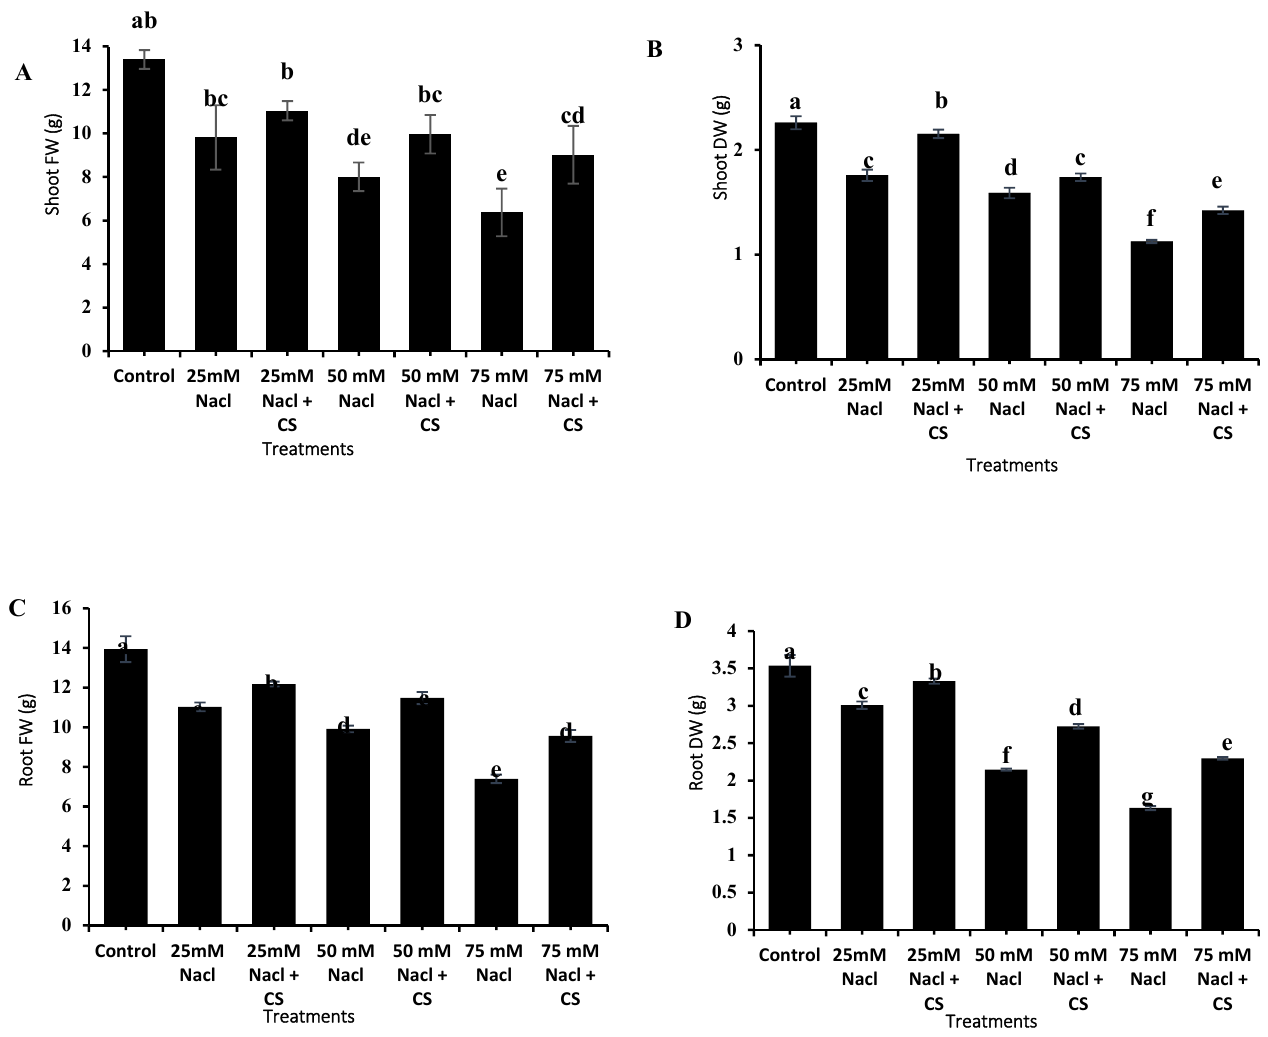
Figure 2. Shoot FW ( A ), Shoot DW ( B ), Root FW ( C ) and Root DW ( D ) of Moringa oleifera exposed to salt stress and sprayed with chitosan (CS) at 1% concentration. Values are means ± SD of two experiments ( n = 6). Columns with different letters are statistically different from each other according to LSD test at p ≤ 0.05.